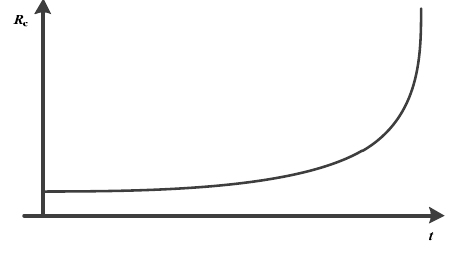
Figure 2. Degradation curve of contact resistance.